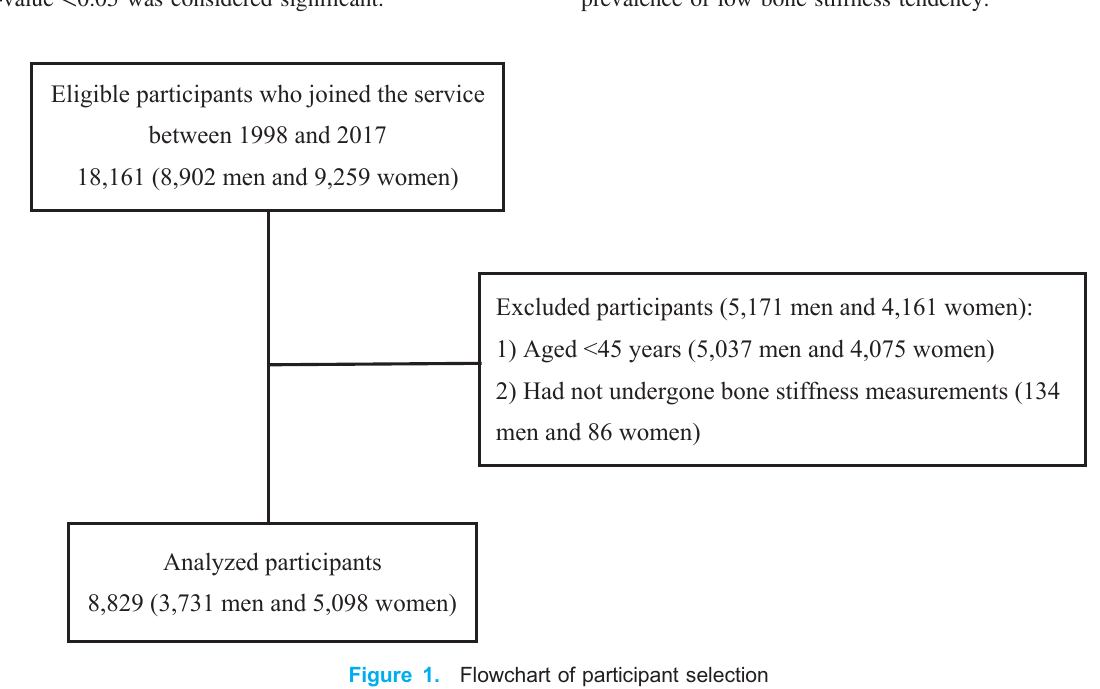
Table 2. Univariate associations of each covariate and two main exposure variables with low bone sti ff ness tendency